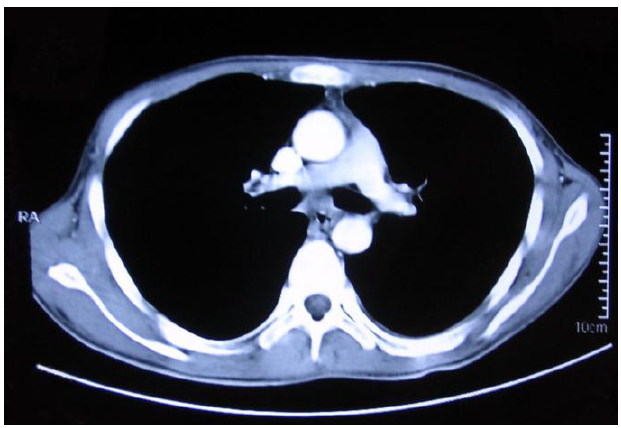
FIGURE 2 . Chest CT on the 5th day of radiotherapy shows re-expansion of the left lung with and return of the mediastinum to the midline. The mass is nearly completely